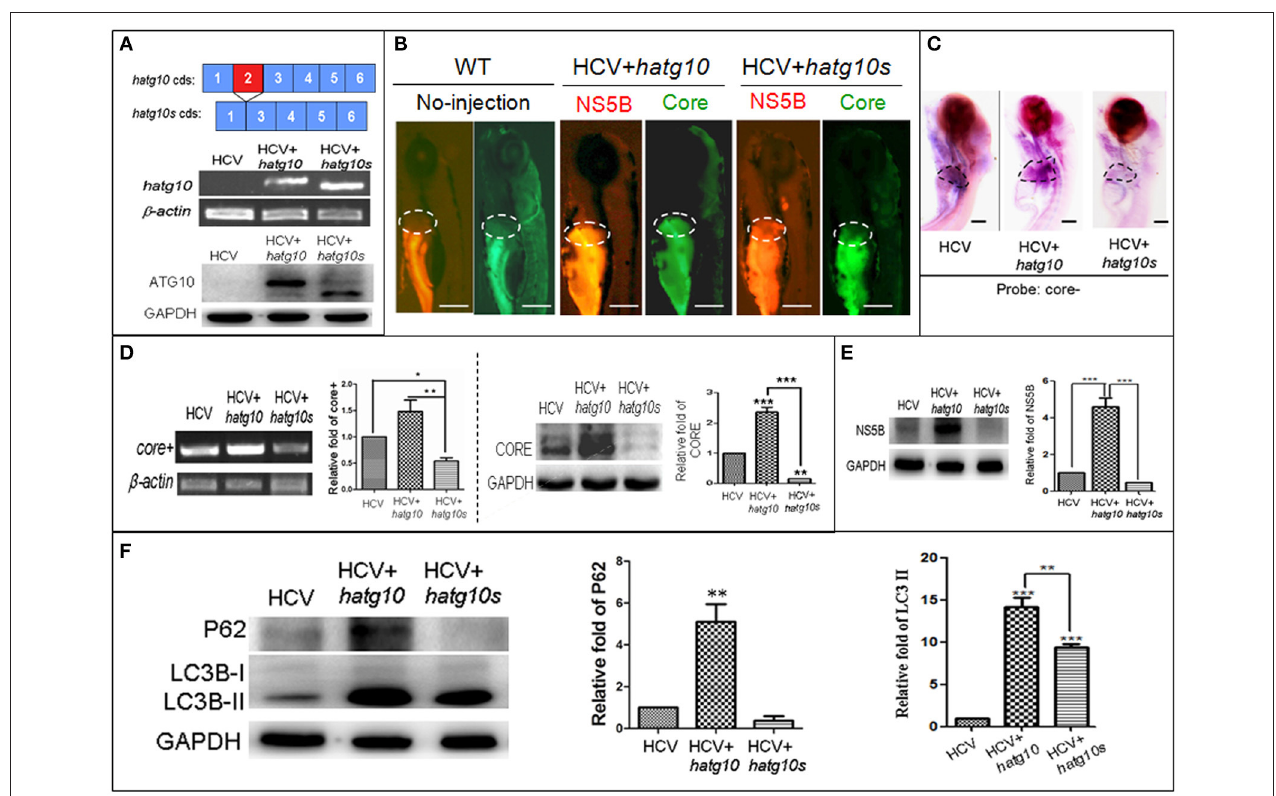
FIGURE 4 | Different effects of two human autophagy related ATG10 and ATG10S on the HCV subgenomic replication and on autophagy flux in zebrafish larvae. (A) Diagrams show the coding regions of both transcripts of the human atg10 gene exons (upper panel). The HCV model larvae were injected either hATG10 expression vector or hATG10S expression vector separately at 1–4 cell stage and collected at 8 dpf for RT-PCR (middle panel) and western blotting (lower panel) detection. The results identified expression of hATG10 and hATG10S in the HCV subreplicon model zebrafish larvae. (B) Living fluorescence imaging shows variable level of the HCV subreplicon in liver of 5 dpf larvae affected by the two hATG10 isoforms. The green fluorescence represents HCV-core protein and the red fluorescence for HCV NS5B protein. Scale bars represent 280 µ m. (C) WISH was used to detect the replication level of the HCV subreplicon by antisense HCV-core RNA probe (core-) in the three groups of no-ATG10 injected HCV model larvae (HCV), hatg10 -injected HCV model larvae (HCV + hatg10 ) and hatg10s -injected HCV model larvae (HCV + hatg10s ). The scales represent 150 µ m. (D) RT-PCR (left panel) and western blotting (right panel) tests indicate the levels of HCV- core + RNA and CORE protein changed differentially by hATG10 and hATG10S in the HCV model larvae, as compared to the no-ATG10 injected model larvae (8 dpf). β -actin and GAPDH were used as sample loading controls. The histograms show relative core + / β -actin ratios and CORE/GAPDH ratios, respectively, from three independent tests. Data are expressed as means ± SD . * p < 0.05, ** p < 0.01. (E) Western blotting results show the level of HCV NS5B protein regulated differentially by ATG10 and ATG10S in the HCV model larvae, as compared to the no-ATG10 injected model larvae (8 dpf). GADPH was used as a loading control. The histogram shows relative NS5B/GAPDH ratios from three independent tests. Data are expressed as means ± SD . *** p < 0.001. (F) Western blotting results show the levels of LC3B-II/I and p62 proteins being regulated differentially by ATG10 and ATG10S in the HCV model larvae, as compared to the no-ATG10 injected model larvae (8 dpf). GADPH was used as a loading control. The histograms show relative LC3-II/GADPH and P62/GADPH ratios from three independent experiments. Data are expressed as means ± SD . ** p < 0.01, *** p <